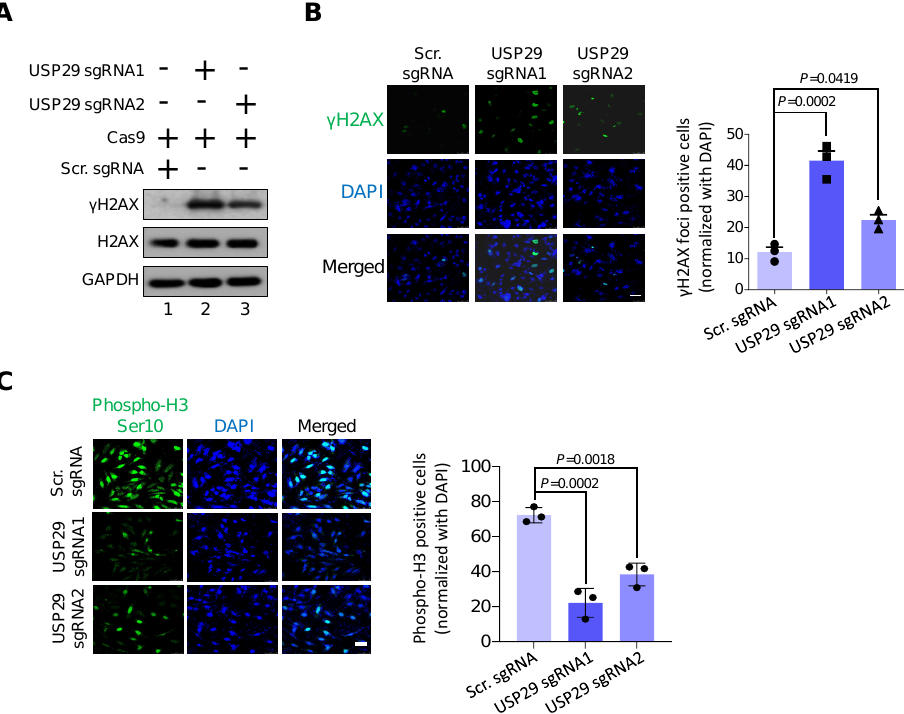
Figure 3. USP29 depletion triggers DNA damage and delays cell-cycle progression . ( A ) HCT116 cells were transfected with the indicated plasmids and analyzed by western blotting using indicated antibodies. GAPDH was used as a loading control. ( B ) γ H2AX foci formation assay was performed to measure the DNA double strand breaks in HCT116 cells. Green, γ H2AX; blue, nucleus stained with DAPI. Scale bar = 50 µ m. The right panel shows the γ H2AX-positive cells normalized with DAPI. ( C ) HCT116 cells were transfected with the indicated plasmids and immunostained with phospho- H3 (Ser10) antibody. The cells expressing phospho-H3 (green fluorescence) were counted and normalized with DAPI (blue fluorescence). Scale bar = 50 µ m. The right panel shows the calculated data, presented as the phospho-H3-positive cells. Data in ( B , C ) are presented as the mean ± standard deviation of three independent trials. p -values were determined by one-way ANOVA followed by Tukey’s post hoc